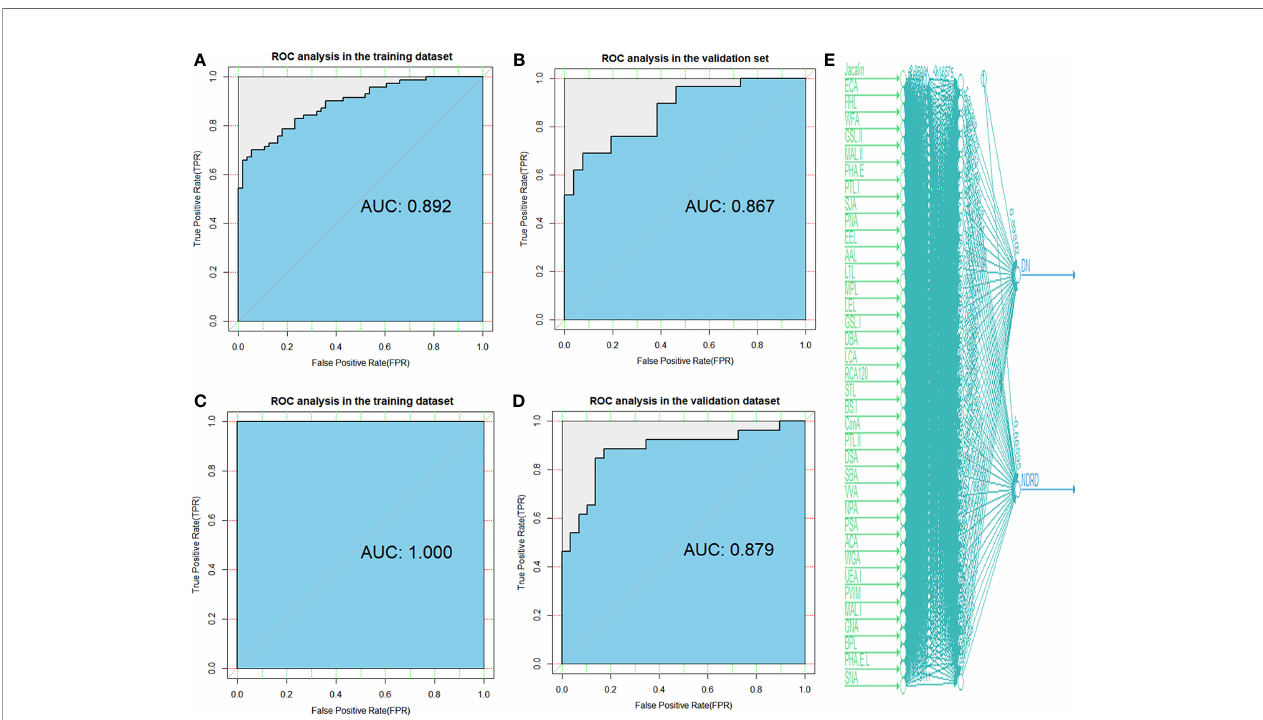
FIGURE 3 | Diagnostic accuracy of selected lectins and models was determined by ROC analysis with logistic regression and arti fi cial neural network methods. ROC analysis for models constructed by logistic regression in the training (A) and validation (B) cohorts. ROC analysis for models constructed by arti fi cial neural network in the training (C) and validation (D) cohorts. (E) A total of 37 candidate lectins for all patients are displayed in arti fi cial neural network analysis. DN, diabetic nephropathy; NDRD, non-diabetic renal disease; ROC, receiver operating